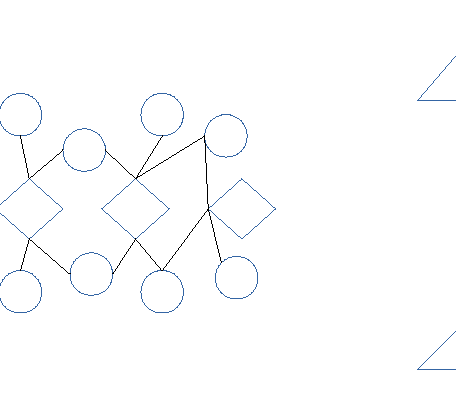
Figure 3. Overview of the heterogeneous graph